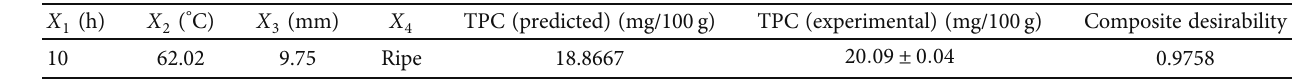
Figure 4: Desirability function with the optimum drying Table 4: Optimum conditions for the drying process.